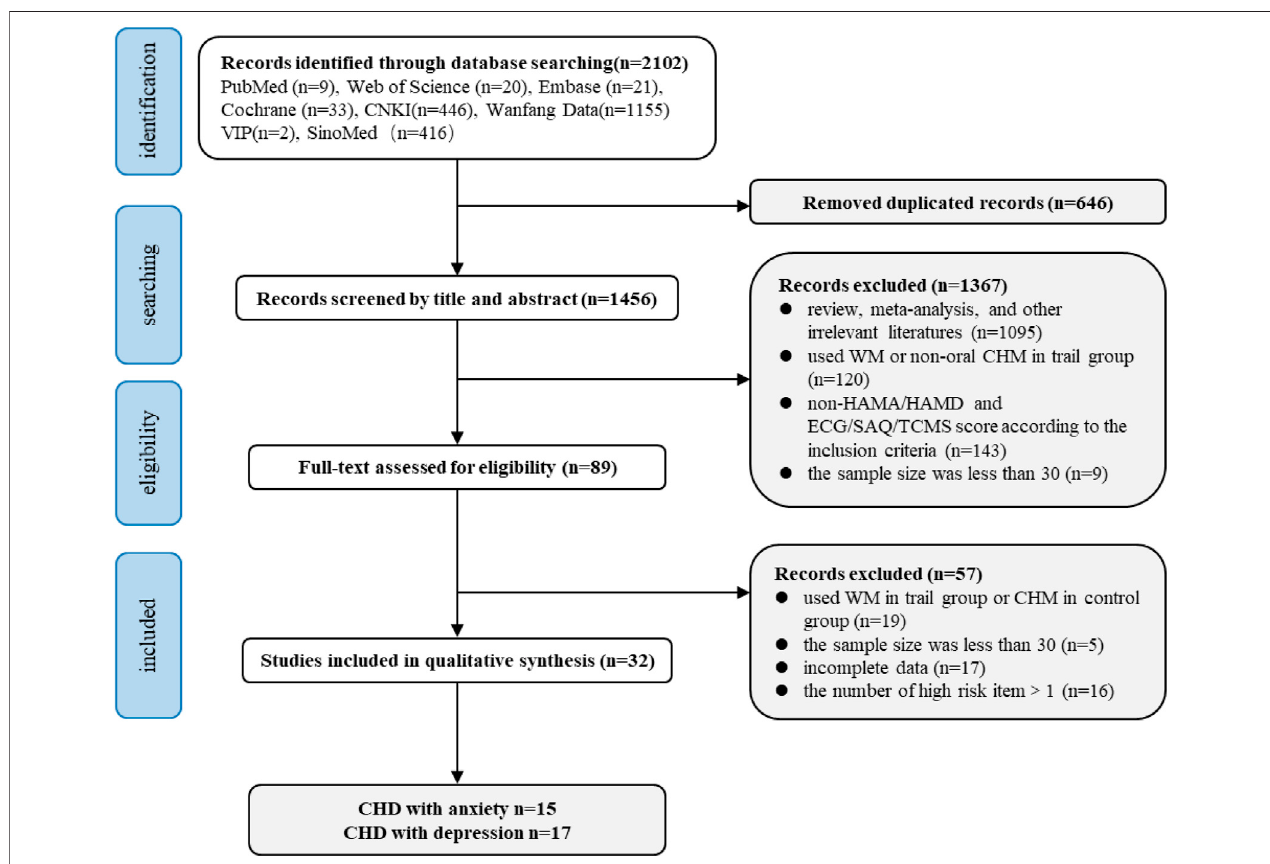
FIGURE 1 | Flow diagram of literature